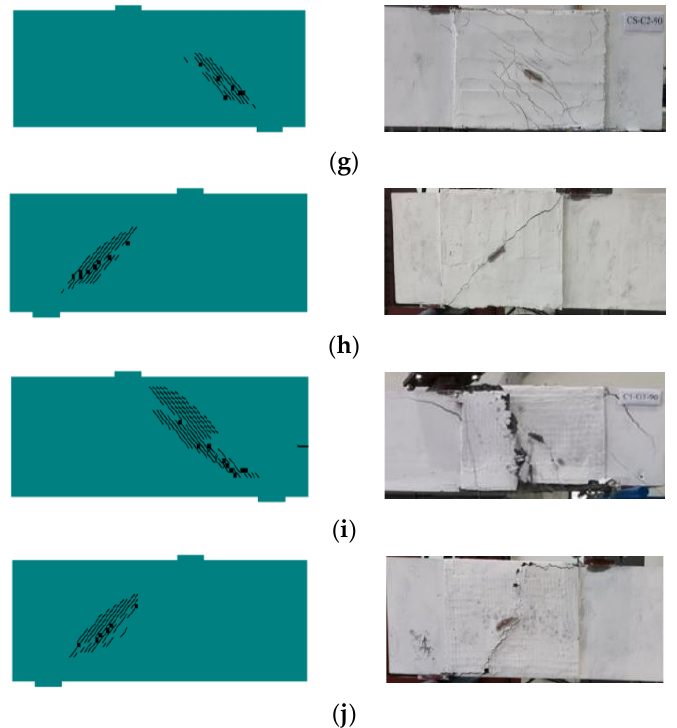
Figure 20. Predicted versus numerical crack pattens: ( a ) Control-NS; ( b ) Control-ST; ( C ) NS-C1-90; ( d ) NS-C2-90; ( e ) NS-C2-0/90; ( f ) ST-C1-90; ( g ) ST-C2-90; ( h ) ST-C2-0/90; ( i ) NS-G1-90; ( j ) ST-G1-90.